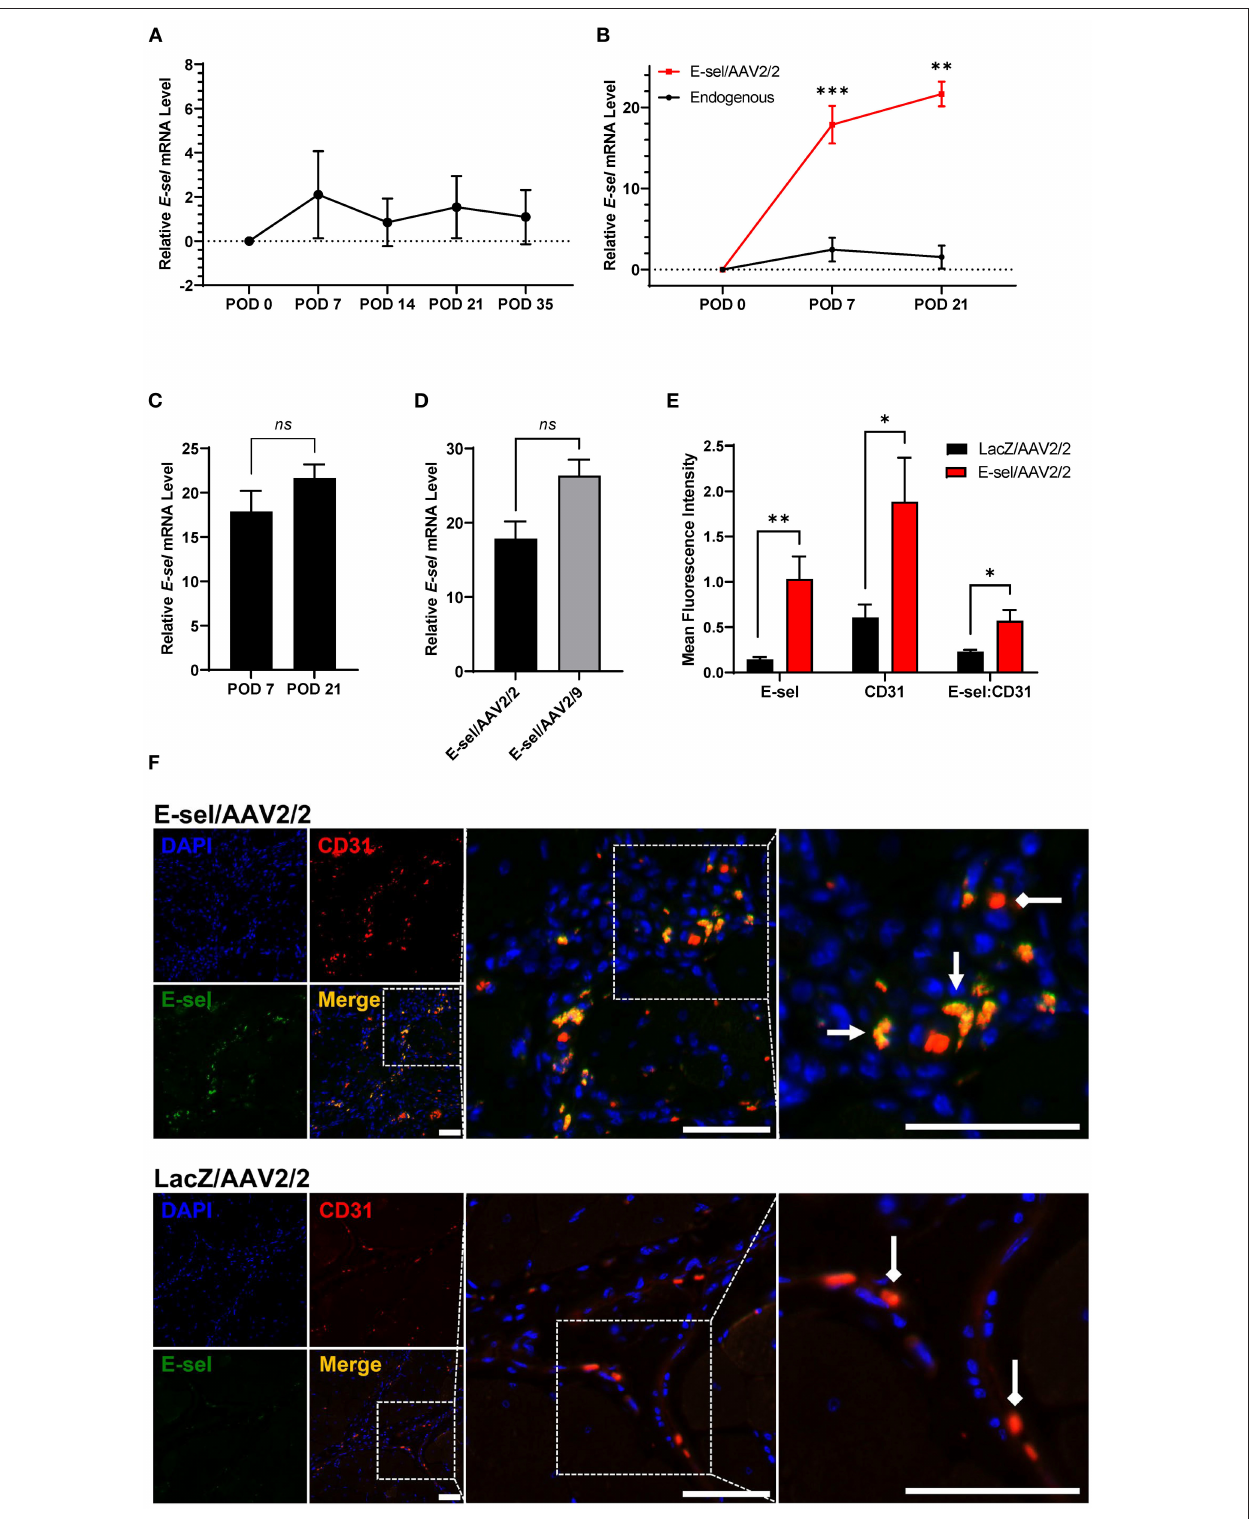
FIGURE 1 | High-level E-selectin expression by E-sel/AAV2/2 treatment in ischemic limb tissues. (A) Endogenous E-sel mRNA measured by RT-qPCR is transiently upregulated in untreated ischemic muscle normalized to untreated non-ischemic muscle. (B) Relative E-sel mRNA in E-sel/AAV2/2-treated ischemic